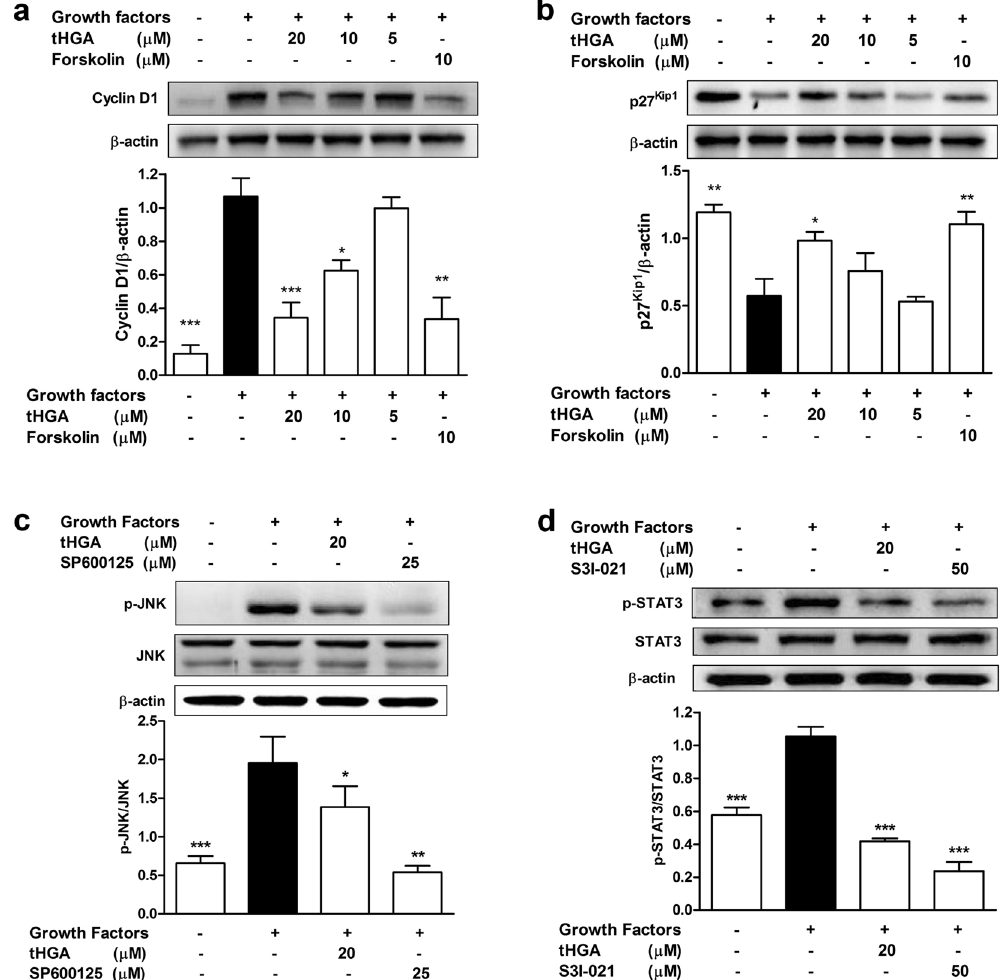
Figure 4. Effects of tHGA on the expression of cell cycle proteins and phosphorylation of proliferation signaling molecules in growth factor-induced hBSMCs. hBSMCs were co-treated with growth factors and tHGA or forskolin for 20 hours, followed by analysis of ( a ) cyclin D1 and ( b ) p27 Kip1 protein expression through immunoblotting. Protein expression of cyclin D1 and p27 Kip1 were normalized to the internal loading control β -actin. Phosphorylation of ( c ) JNK and ( d ) STAT3 in growth factor-induced hBSMCs upon tHGA treatment were assessed through immunoblotting. hBSMCs were serum-starved overnight before co-treatment with growth factors and tHGA or respective inhibitors (SP600125 or S3I-201) for 1 hour. Proteins were immunoblotted with respective antibodies and the protein bands were quantified by densitometry. Results of ( c ) phospho-JNK and ( d ) phospho-STAT3 were presented after normalization with total JNK and STAT3 respectively. Representative cropped blots are presented (full-length blots are presented in Supplementary Fig. S4). Results are presented as mean ± SEM of 3 independent experiments. * P < 0.05, ** P < 0.01 and *** P < 0.001, significantly different from growth factor